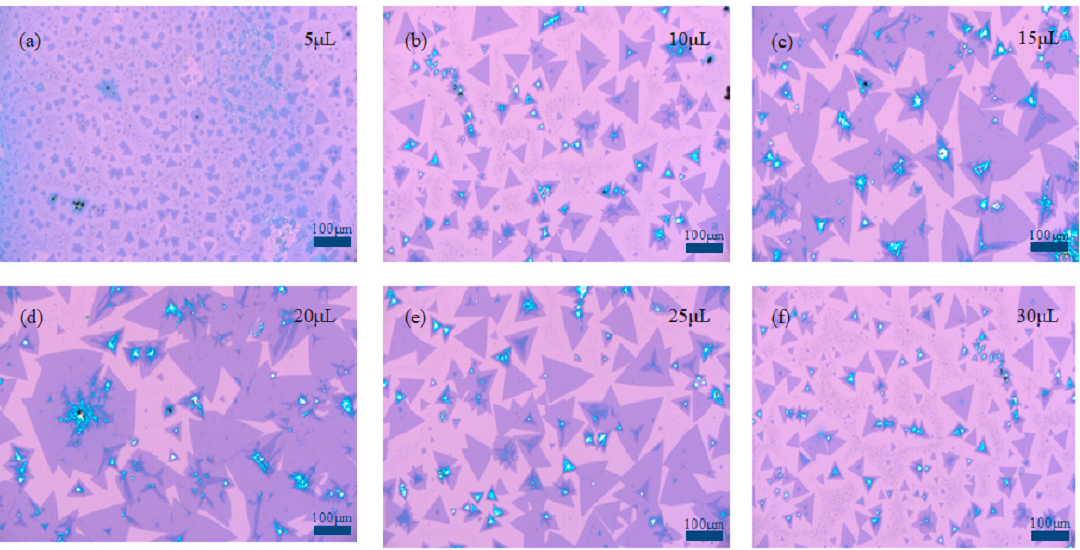
Figure 3. Effect of grapheme quantum dot solution with different dosage on the growth of MoS 2. ( a ) 5 μ L, ( b ) 10 μ L, ( c ) 15 μ L, ( d ) 20 μ L, ( e ) 25 μ L, ( f ) 30 μ L.